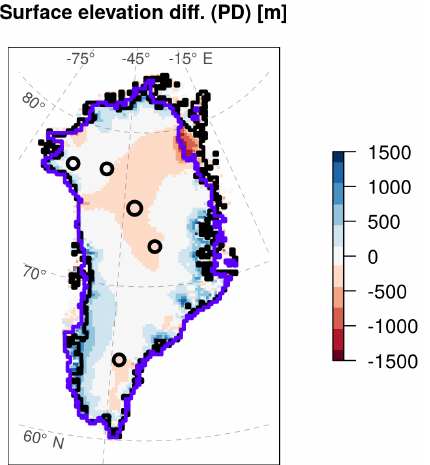
Figure 12. GrIS total extent (ice shelves are included) simulated at the peak of the last glaciation for (a) no melting/freezing at the grounding line (cyan) and (b) κ = 0, 1 and 10ma − 1 K − 1 (red, green and purple lines, respectively) for B ref = 1ma − 1 . The tim- ing of the glacial maximums is (a) 12kyrBP and (b) 10, 20 and 14kyrBP for κ = 0, 1 and 10ma − 1 , respectively. LGM (21kyrBP) GrIS grounding-line position estimated by Lecavalier et al. (2014) is shown for comparison (black line).